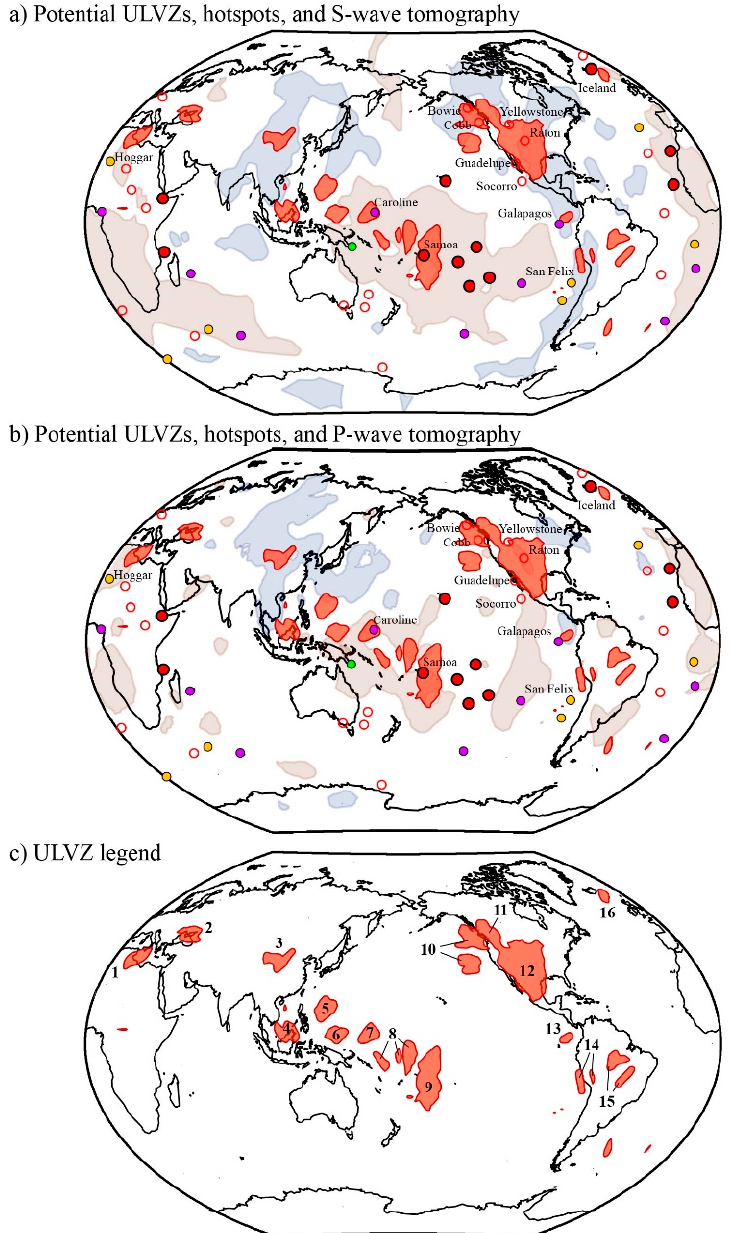
Figure 9. ( a ) We show the locations of the most probable ULVZs as solid red-filled regions. These are compared to the locations of the lowest (pink-filled regions) and highest (light-blue-filled regions) S-wave velocities from tomography model GyPSum [42], as contoured in Figure 5. Possible hotspots associated with deep plumes from the study of French and Romanowicz are also shown [41], and additional hotspot locations not considered in that study [48]. Select hotspots that are discussed in the text are labeled. ( b ) Same as in panel (a), except with P-wave velocities from tomography model DETOX-P2 [43] ( c ) High-probability ULVZ locations are numbered for reference to discussion in the manuscript.